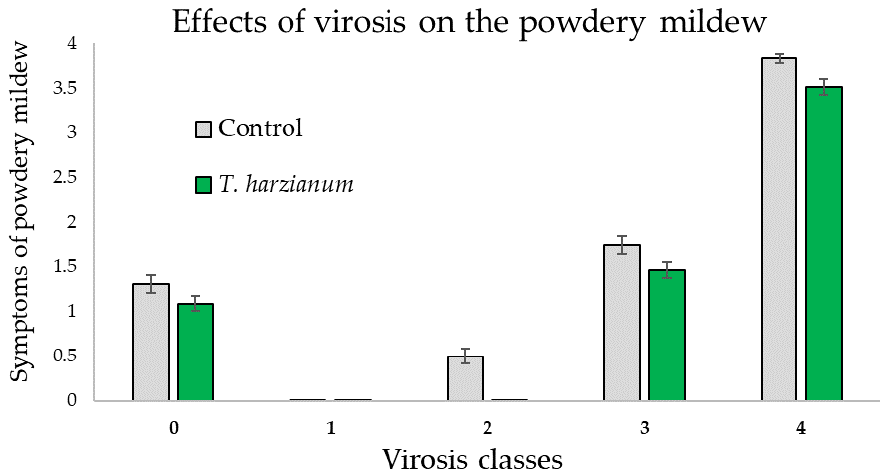
Figure 6. Mean values ( ± standard errors) of the symptoms the powdery mildew in relation to the virus classes in plants inoculated with T. harzianum T22 and control ones.